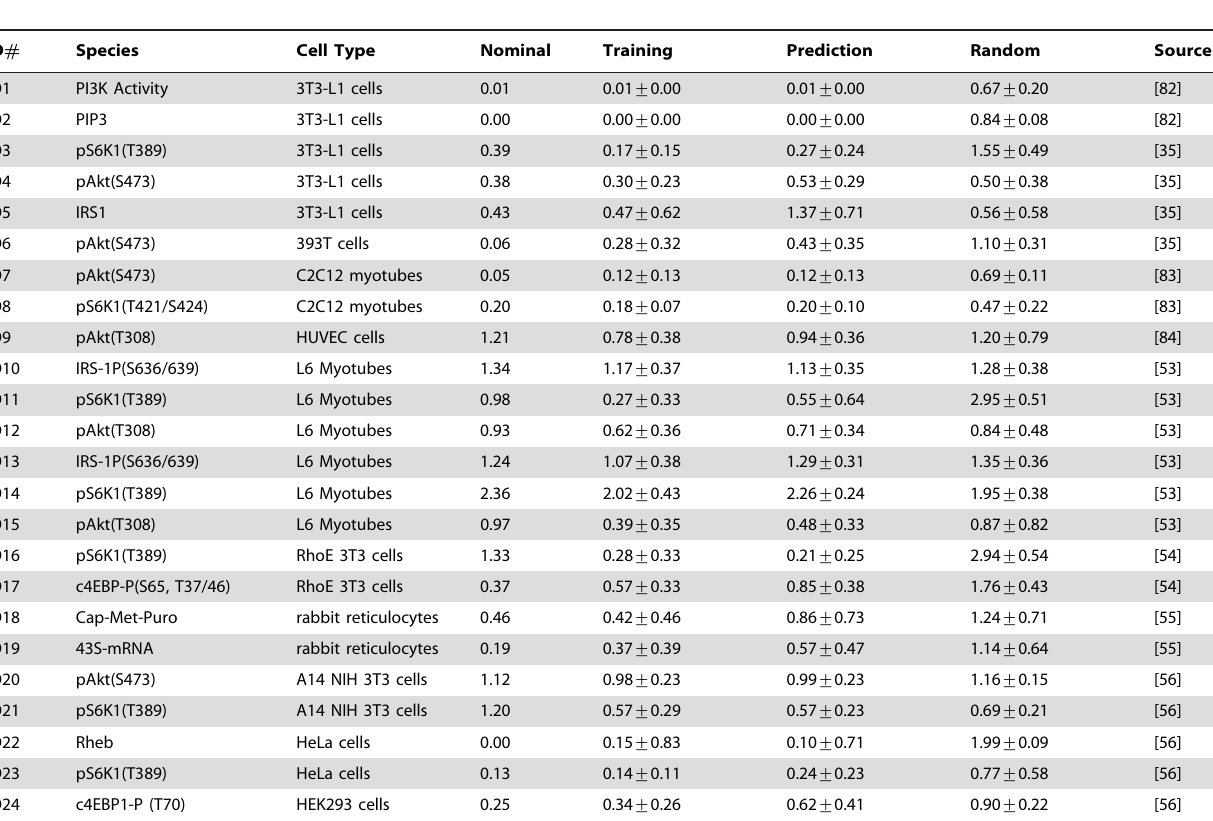
Fig. 2. The majority of objective functions were uncorrelated e.g., Table 1. Objective function list along with species, cell type, cellular compartment, nominal error, training error, prediction error, random error with a randomly generated parameter set and the corresponding literature